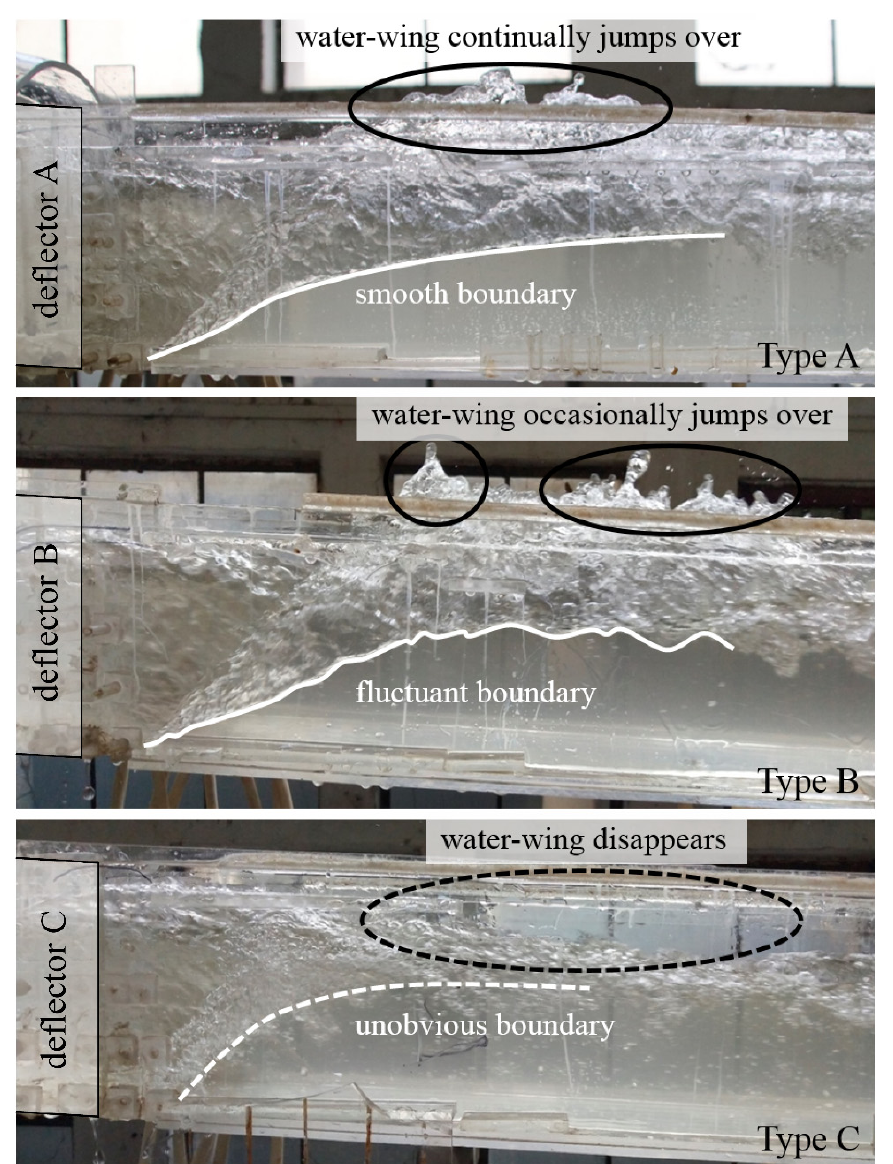
Figure 4. Side view of the flow pattern downstream of the deflectors.